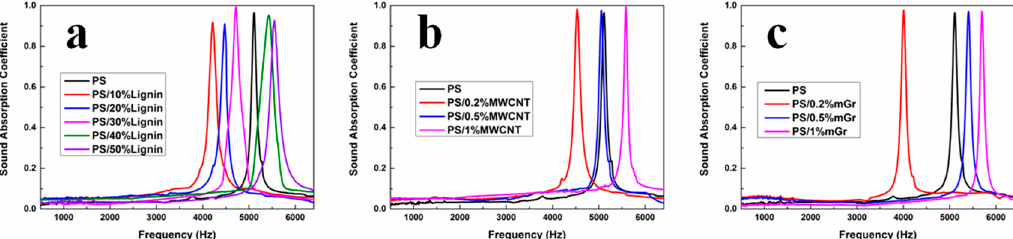
Figure 4. Sound absorption property of PS composite foams: ( a ) PS/lignin; ( b ) PS/MWCNT; ( c ) PS/mGr.